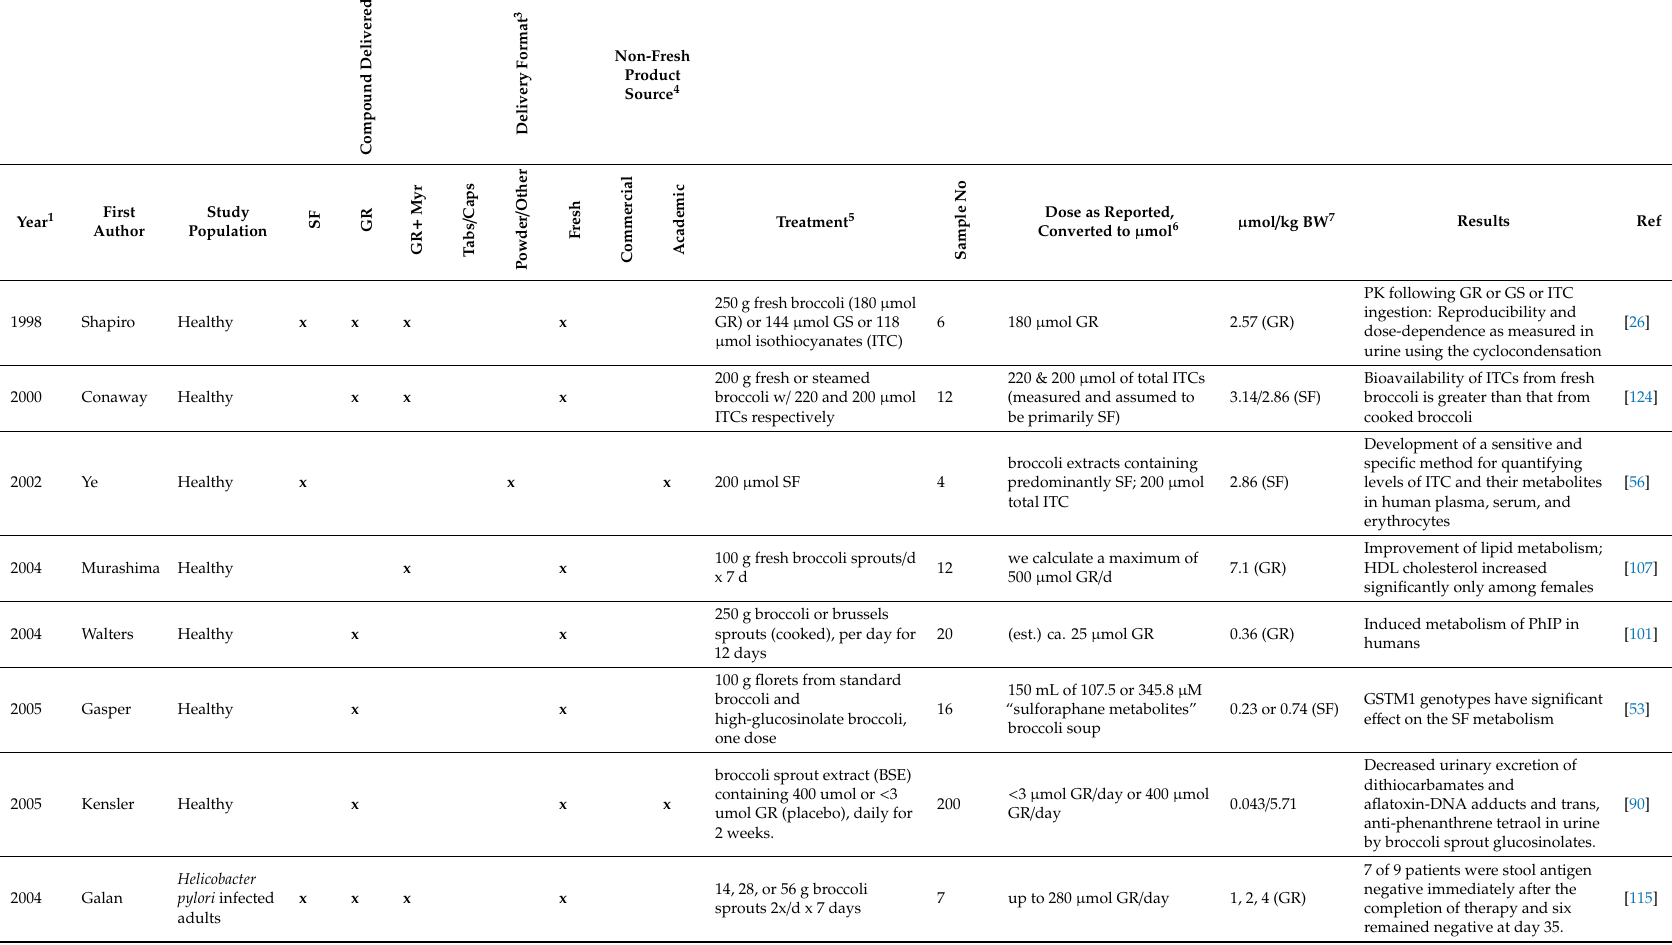
Table 1. Summary of Clinical Trials with Broccoli, Glucoraphanin or